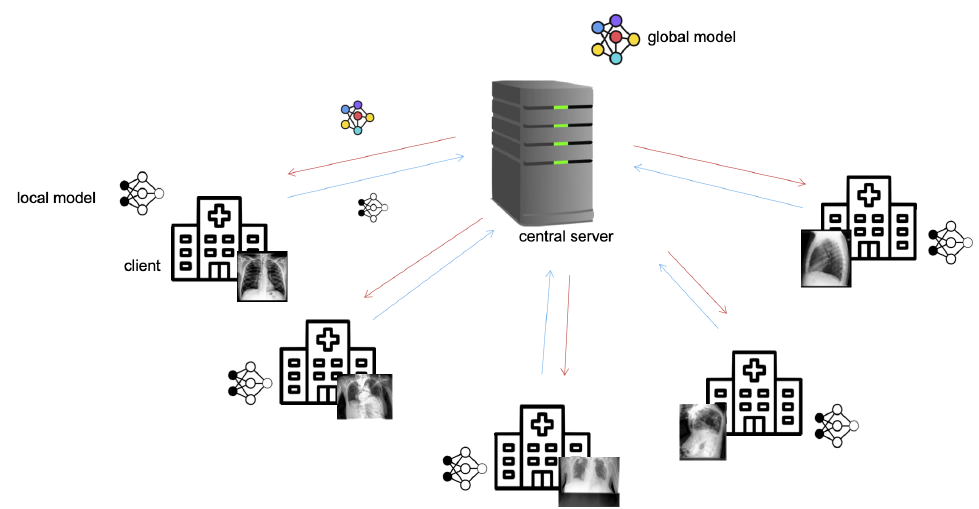
Figure 1. In the federated learning setup, the server first initializes a model and distributes the model parameters to its clients. Over several iterations, each client trains the model individually on its data for a defined number of local epochs, sends the parameters of its locally trained model back to the server for aggregation, and receives a global model, aggregated from all trained local